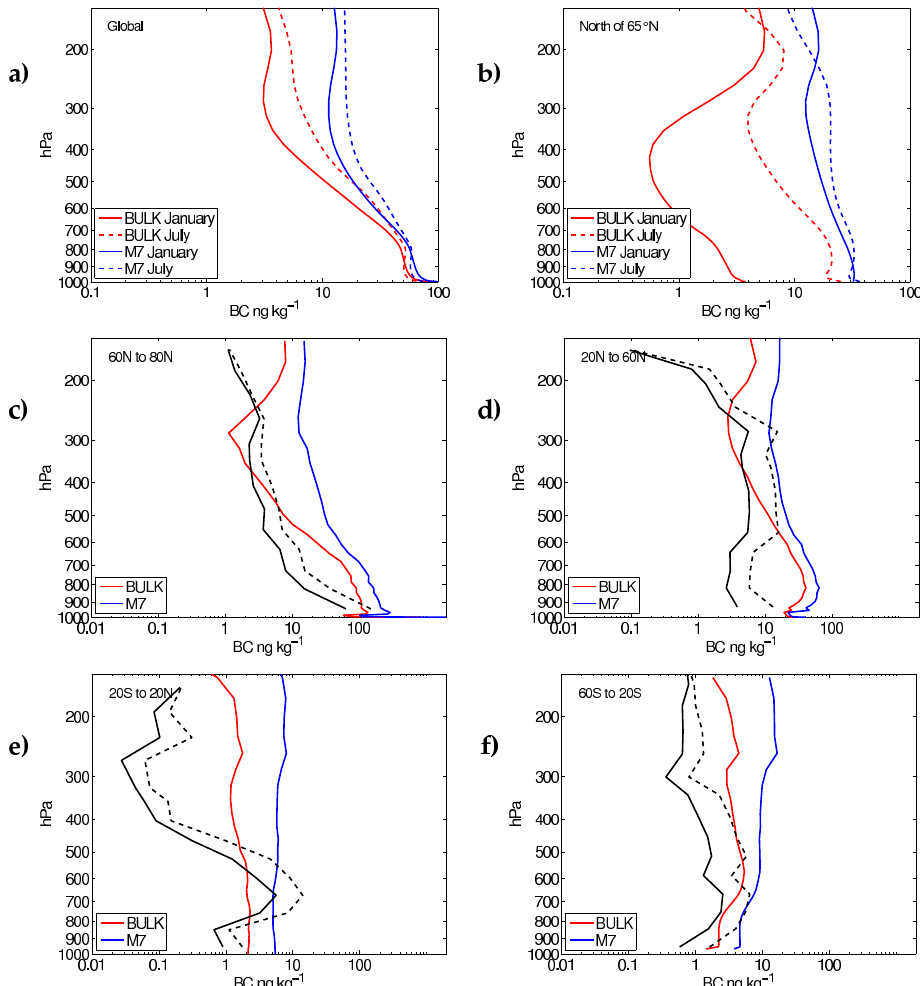
Fig. 2. Vertical distribution of BC [ngkg − 1 ] averaged (a) globally and (b) north of 65 ◦ N with BULK (red) and M7 (blue) in January (solid) and July (dashed). (c) to (f) shows modelled vertical distribution in January compared to measurements (solid black line, dashed line gives +1SD) over the Pacific Ocean from Schwarz et al.